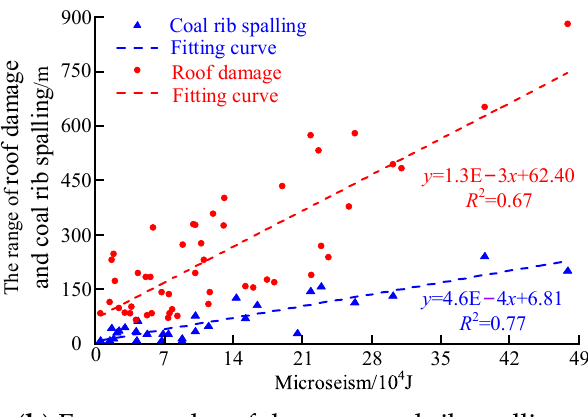
( b ) Energy and roof damage, coal rib spalling. Figure 7. Correlation between microseism events and roof damage, coal rib spalling.